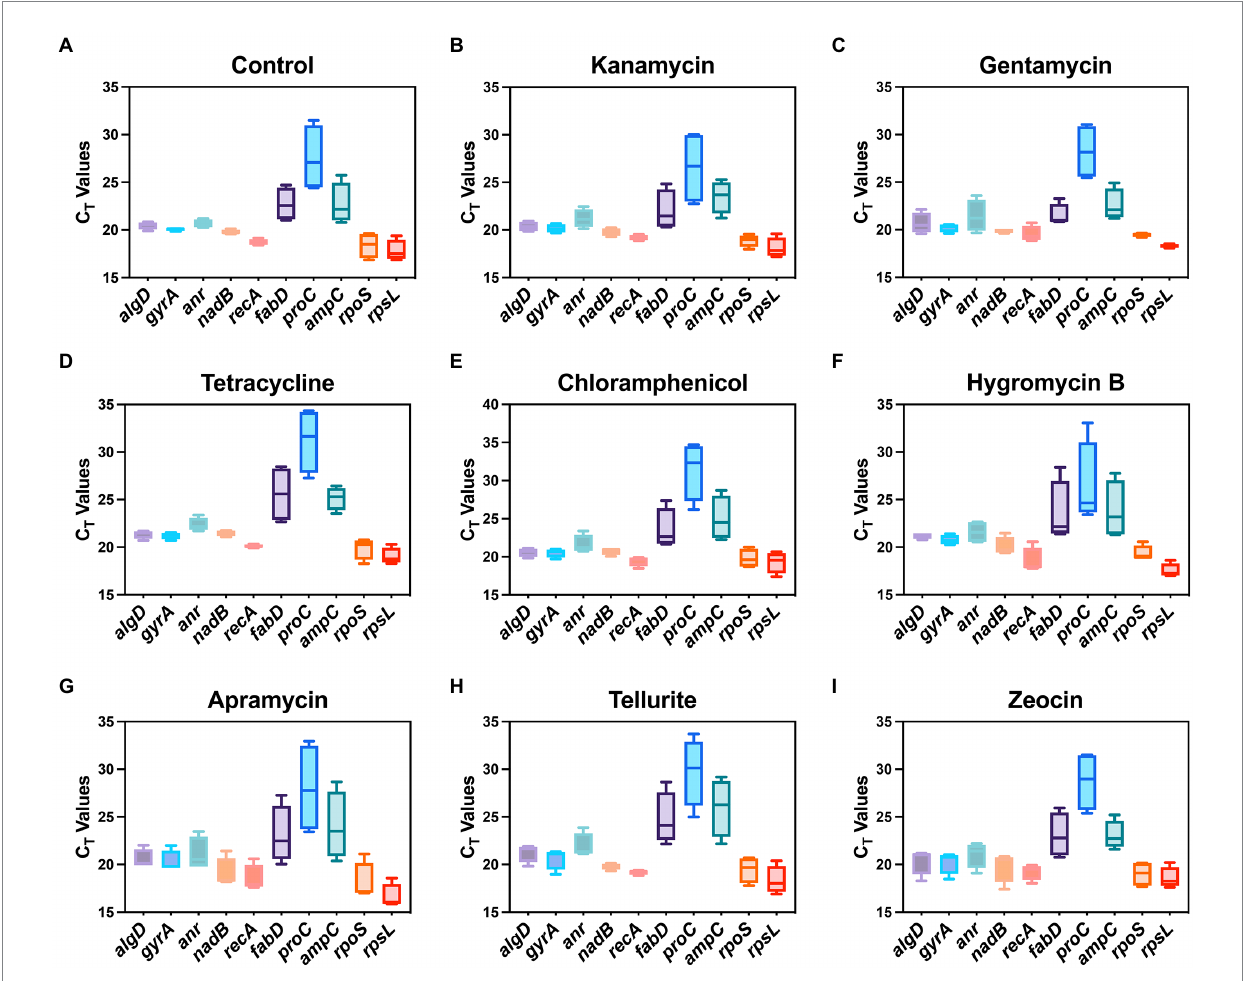
FIGURE 1 Range of real-time PCR cycle threshold (C T ) values of 10 housekeeping genes in P. aeruginosa under 8 antibiotic pressures. (A) Control; (B) kanamycin; (C) gentamycin; (D) tetracycline; (E) chloramphenicol; (F) hygromycin B; (G) apramycin; (H) tellurite; (I) zeocin.